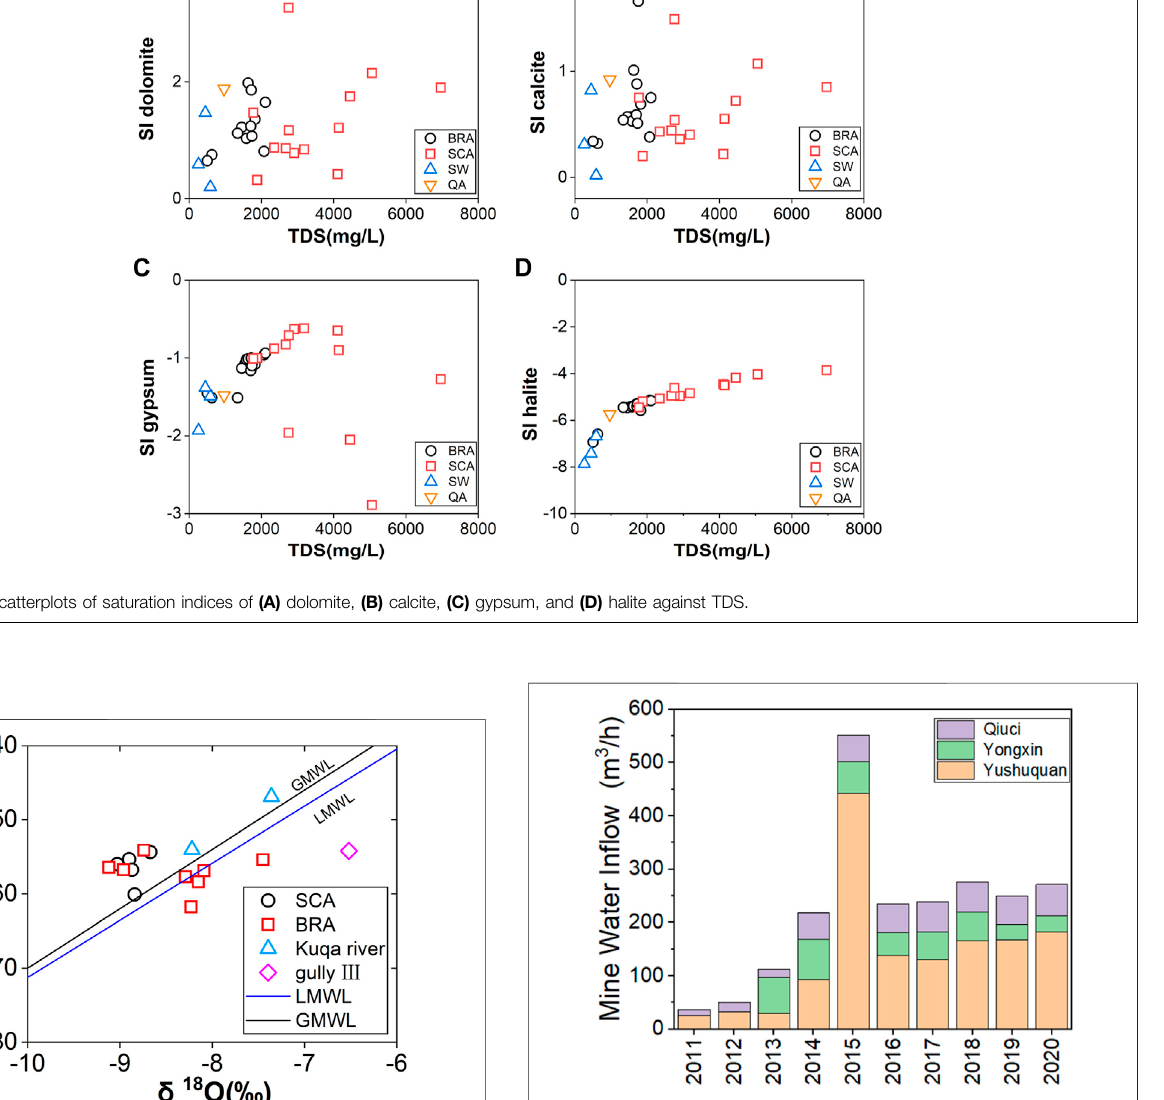
FIGURE 10 | Relationship between δ D and δ 18 O isotopic concentrations.